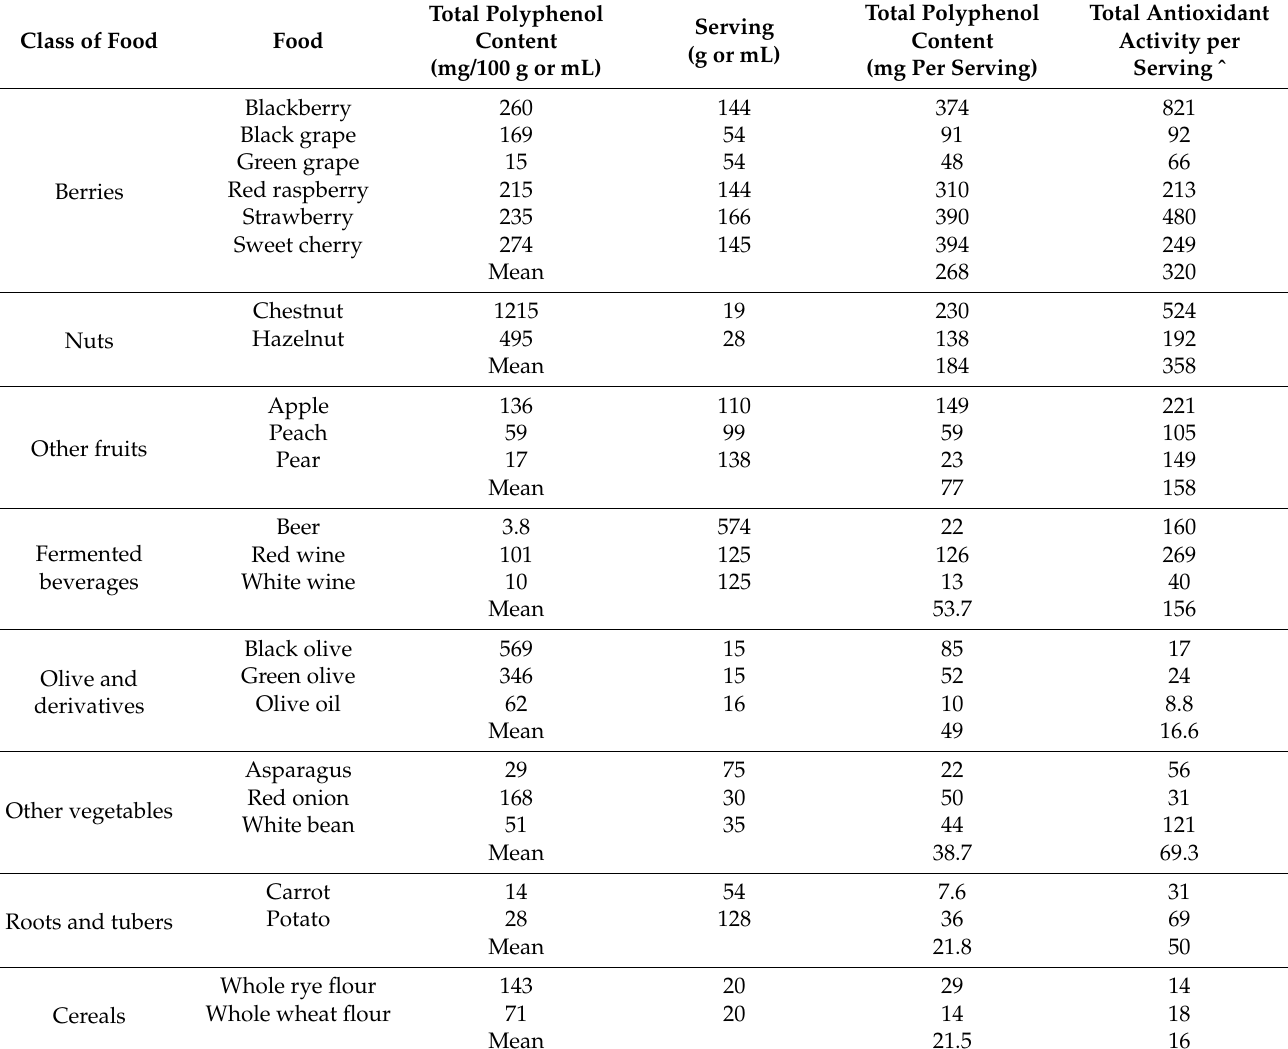
Table 3. Total polyphenol content in some foods (Modified from